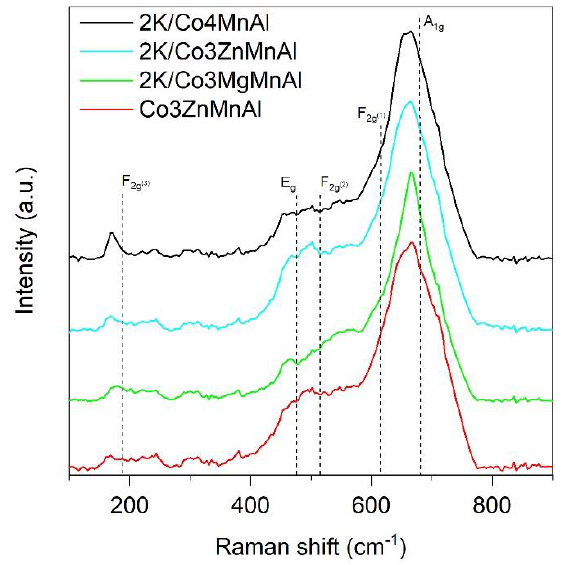
Figure 3. Raman spectra of mixed oxide catalysts. Raman bands position according to [48].